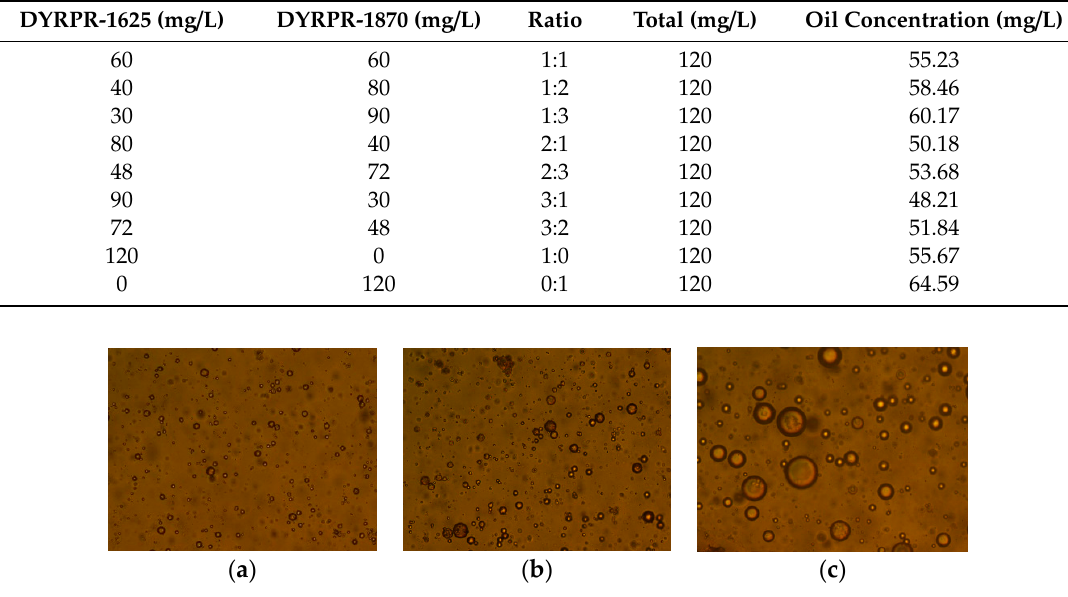
Figure 1. Effect of ZY demulsifier on oil droplets. ( a ) At 0 min settling with no ZY demulsifier; ( b ) At 4 h settling with no ZY demulsifier; ( c ) At 4 h settling with ZY demulsifier.